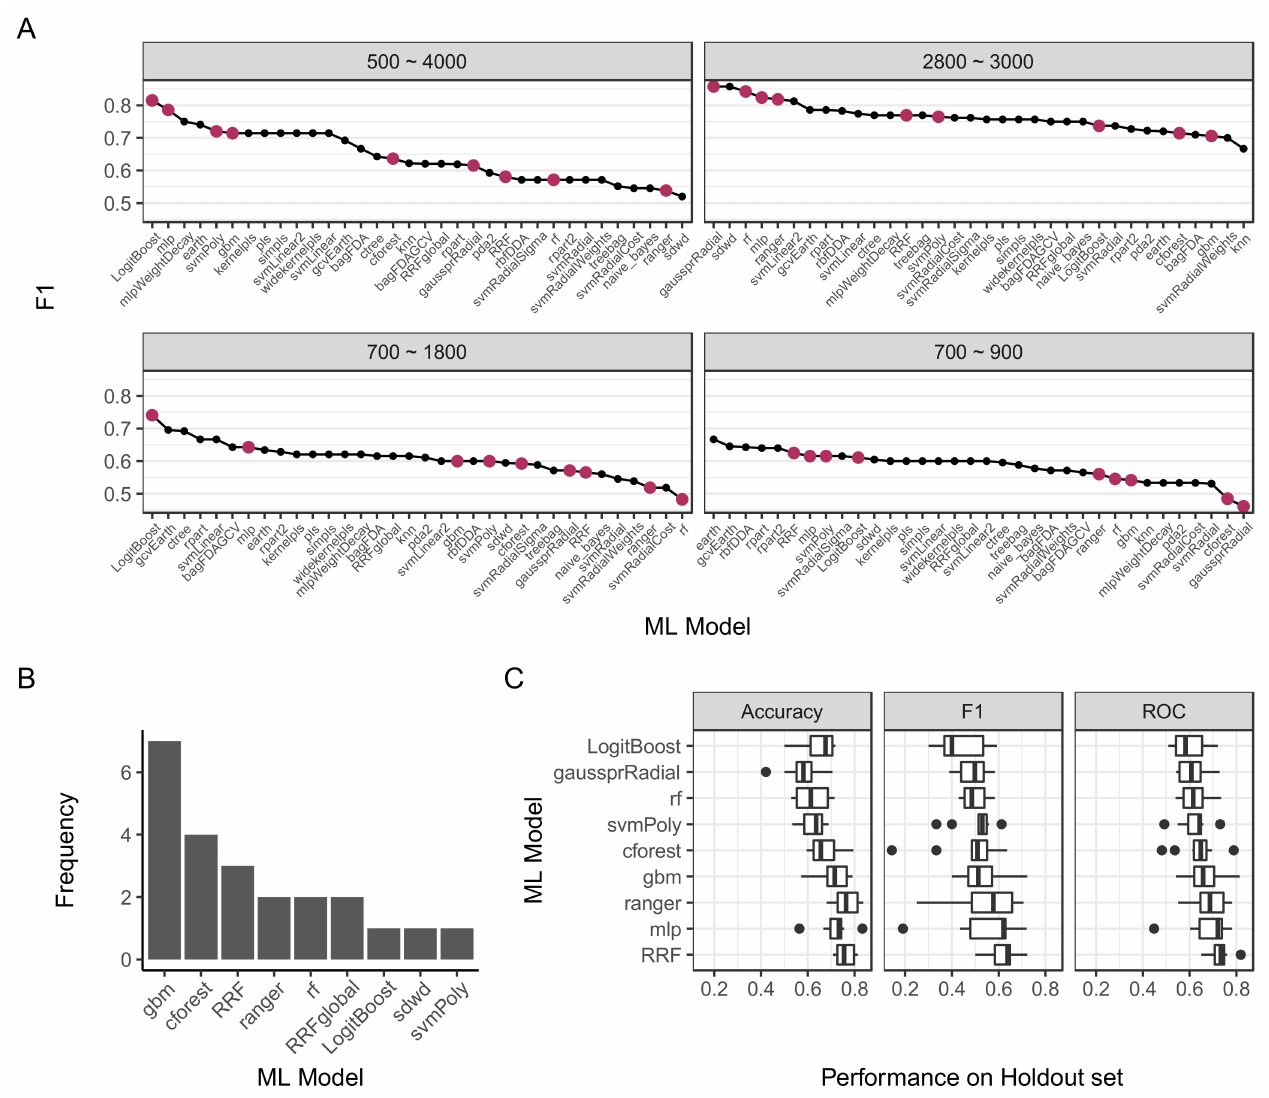
Figure 3. Machine learning model selection and validation. ( A ) Top performance F1 score for each model against different spectrum ranges. Maroon dots represent models selected for further validations. ( B ) Models with high accuracy in both training set, as estimated by ROC > 0.8 in cross-validation, and in the test set (F1 score > 0.5). Frequency indicates the number of processing parameter combinations in a specific model achieved by these criteria. ( C ) Performance scores of selected models on test sets. Dataset splitting and model fitting were repeated 10 times, and performance was evaluated with three